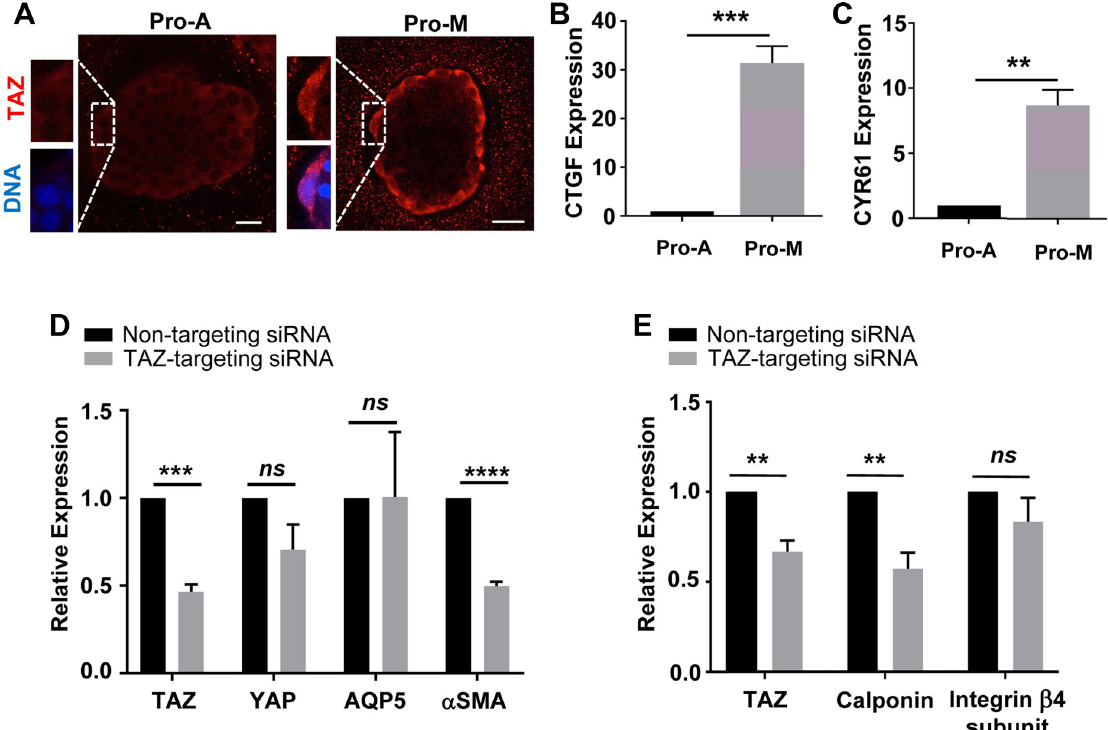
Fig 7. mSG-PAC1 cells cultured in Pro-M medium display characteristics of myoepithelial cells. (A) Increased expression of TAZ in the cells at the periphery mSG-PAC1 spheroids cultured in Pro-M. Representative confocal images from 2 independent experiments of mSG-PAC1 cells cultured for six days in Matrigel in either Pro-A or Pro-M medium and immunostained for TAZ (red) and DRAQ5 (pseudocolored blue). Insets represent a magnified view of nuclear staining. Images are maximum projection images of two z-slices acquired at 40X in 0.4 μ m steps. Size bar, 25 μ m. (B, C) Relative mRNA expression of YAP/TAZ target genes, CTGF (B) and CYR61 (C) , in mSG-PAC1 cells cultured in Matrigel in either Pro-A or Pro-M medium. Expression normalized to β -actin and the expression in Pro-A medium. Data are from three independent experiments plotted as the mean ± s.e.m. analyzed by Student’s T-test. �� p < 0.01; ��� p < 0.001. (D) SiRNA targeting TAZ expression inhibits the expression of α -SMA. Plotted is the relative mRNA expression of YAP, TAZ, AQP5, and α -SMA in mSG-PAC1 spheroids cultured in Matrigel in Pro-M medium. Expression is normalized to β -actin and the expression in cells treated with non-targeting (NT) siRNA. Data are from 4 independent experiments and plotted as the mean ± s.e.m. analyzed by Student’s T- test. ns , not significant, �� p < 0.01; ��� p < 0.001; ���� p < 0.0001. (E) SiRNA targeting TAZ also inhibited the expression of calponin, but not the expression of the integrin β 4 subunit. Plotted is the relative RNA expression of TAZ, calponin, and the integrin β 4 subunit in mSG-PAC1 spheroids cultured in Matrigel and Pro-M medium. Expression is normalized to β -actin and the expression of these genes after treatment with NT siRNA. Data are from three (calponin) and four (TAZ, Integrin β 4) independent experiments and plotted as the mean ± s.e.m. analyzed by Student’s T-test. ns , not significant, �� p <